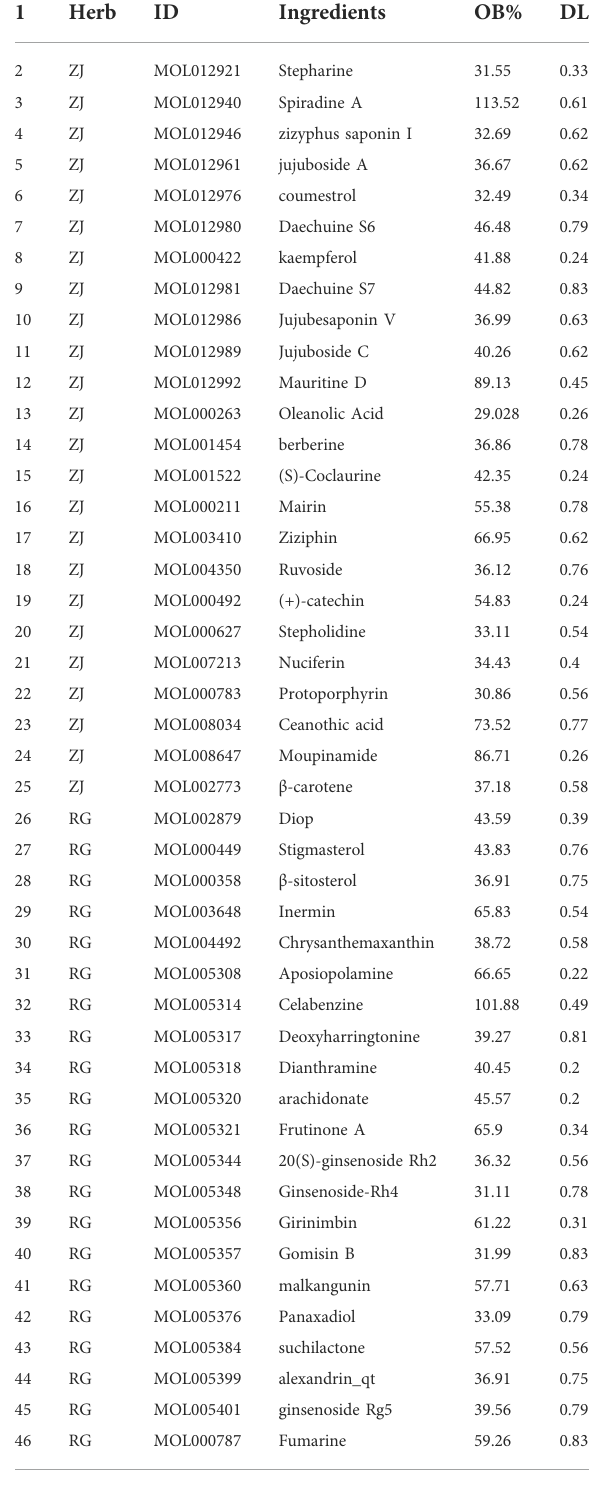
TABLE 1 Active Ingredients of the RG- ZJ herb